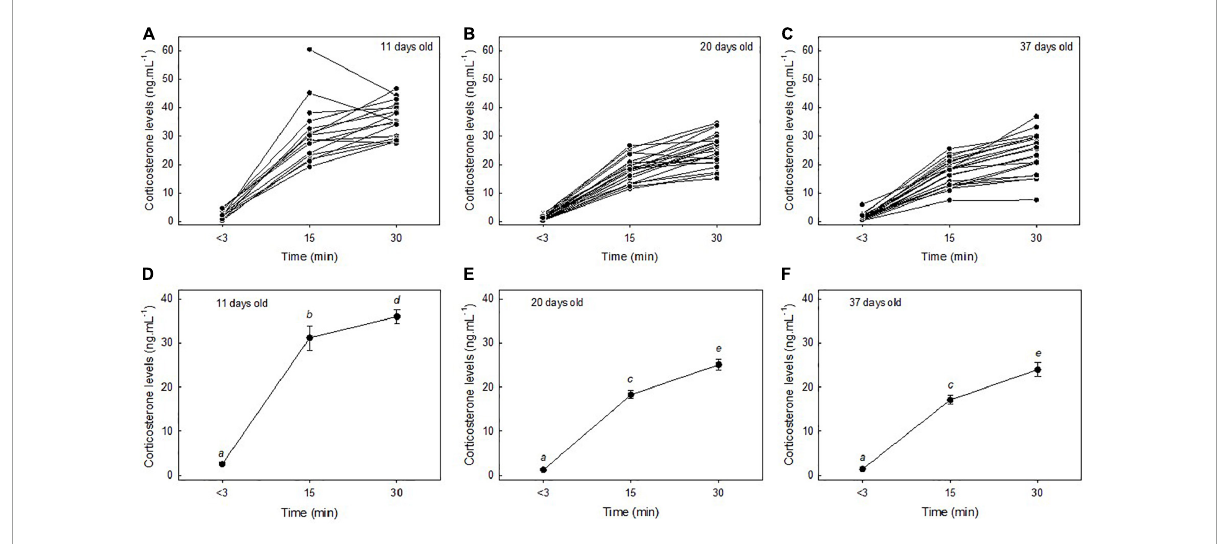
FIGURE1 Inter-individual variability of the corticosterone stress response in snow petrel chicks at 11-days old (A) , 20-days old (B) , 37-days old (C) , and influence of the age of the chick on the corticosterone stress response (D–F) . Mean ± SE are represented and different letters indicate significant differences. Note that one data point with very high corticosterone levels was potentially a statistical outlier (stress-induced corticosterone levels at 15 min in 11-days old chicks: > 60 ng/mL). All statistical tests remained similar if this data point was omitted from the data set.